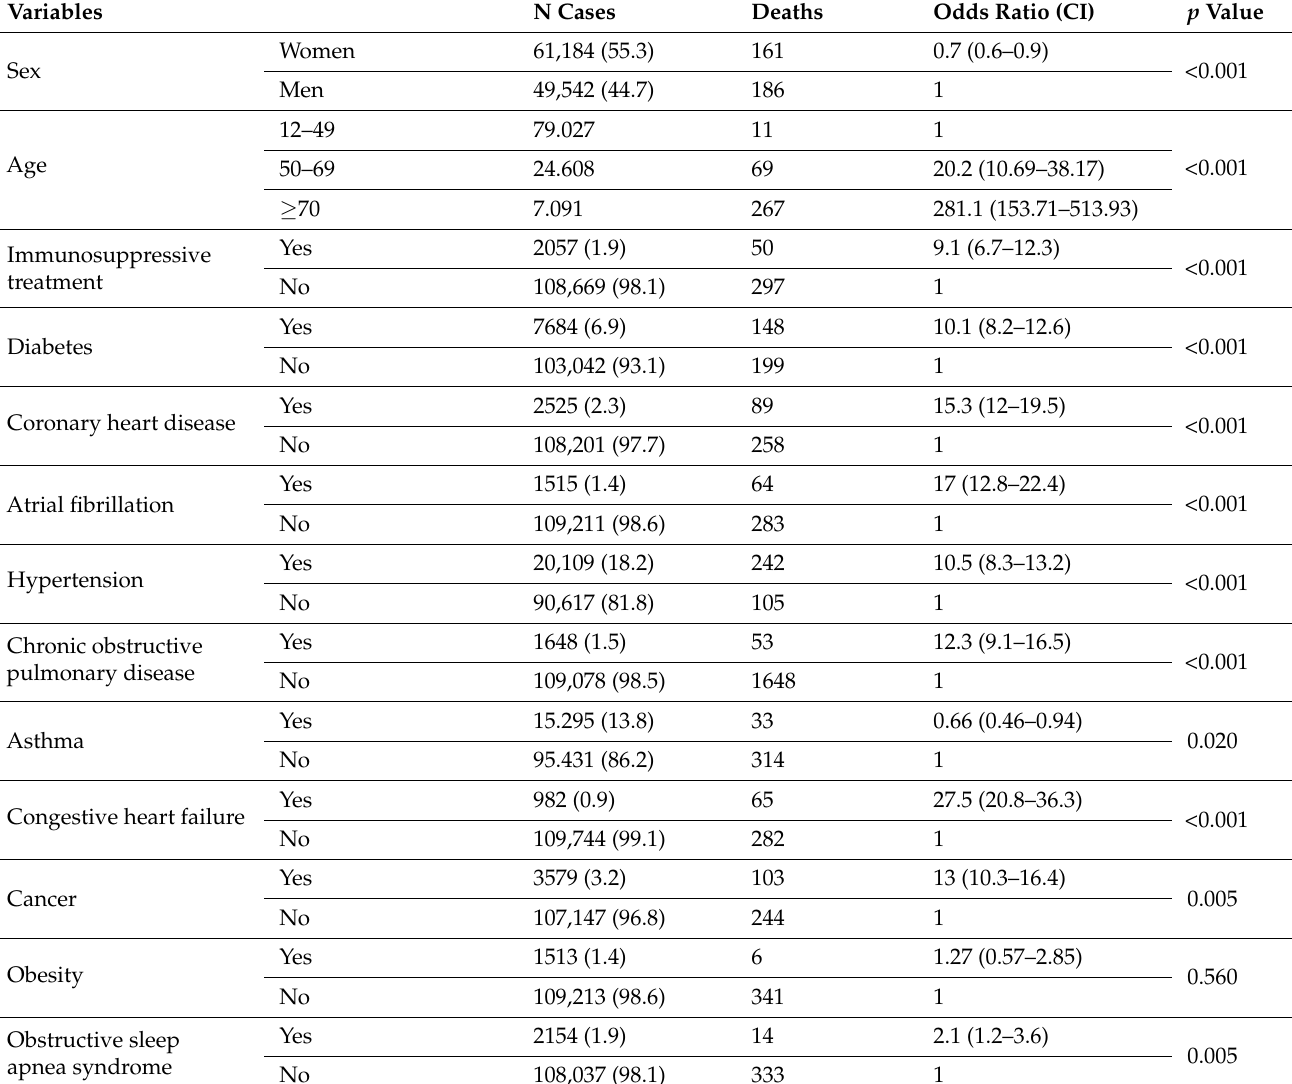
Table 2. Association between predictor variables and death in 110,726